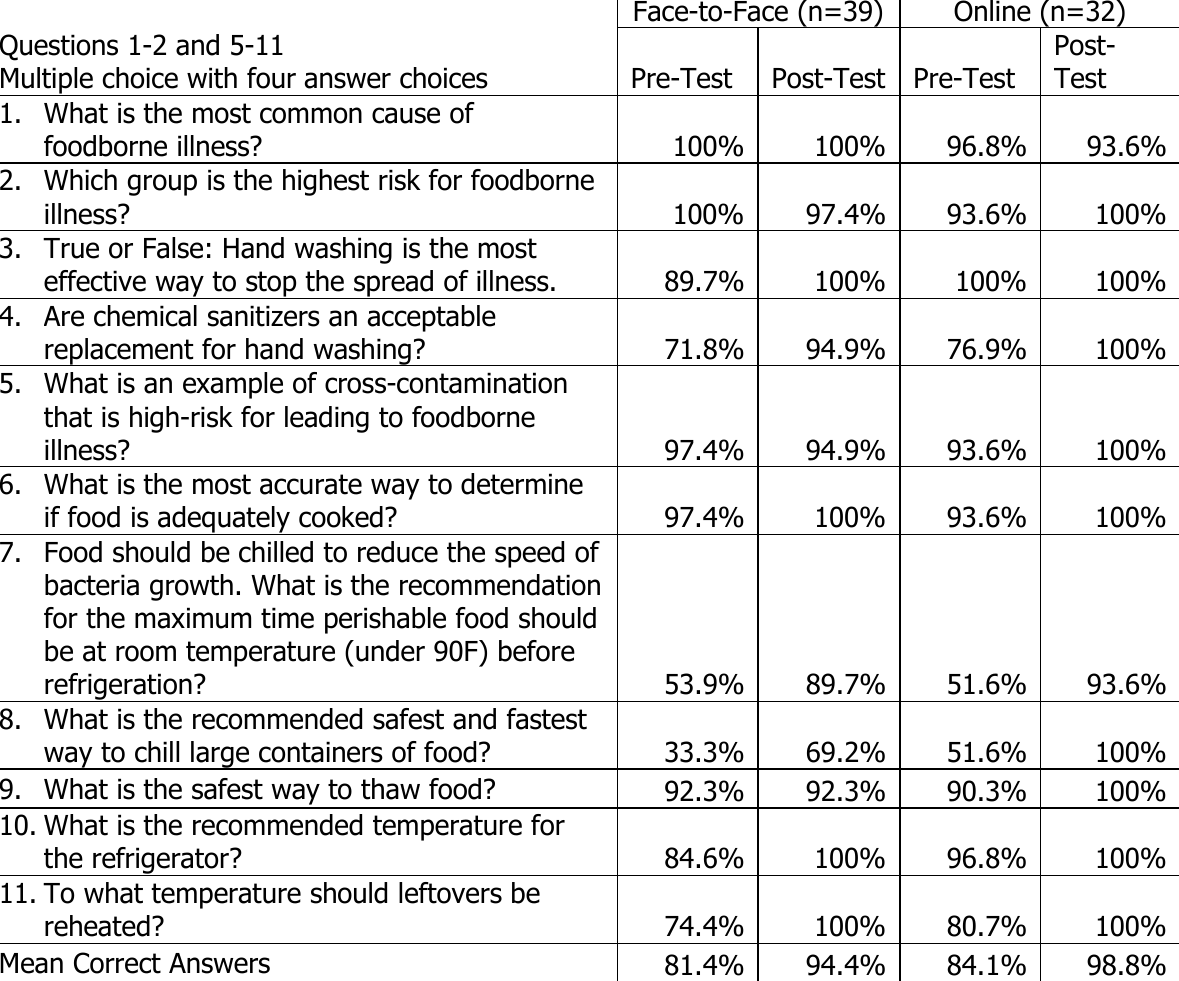
Pre/post Food Safety Knowledge Quiz results of percentage of questions answered